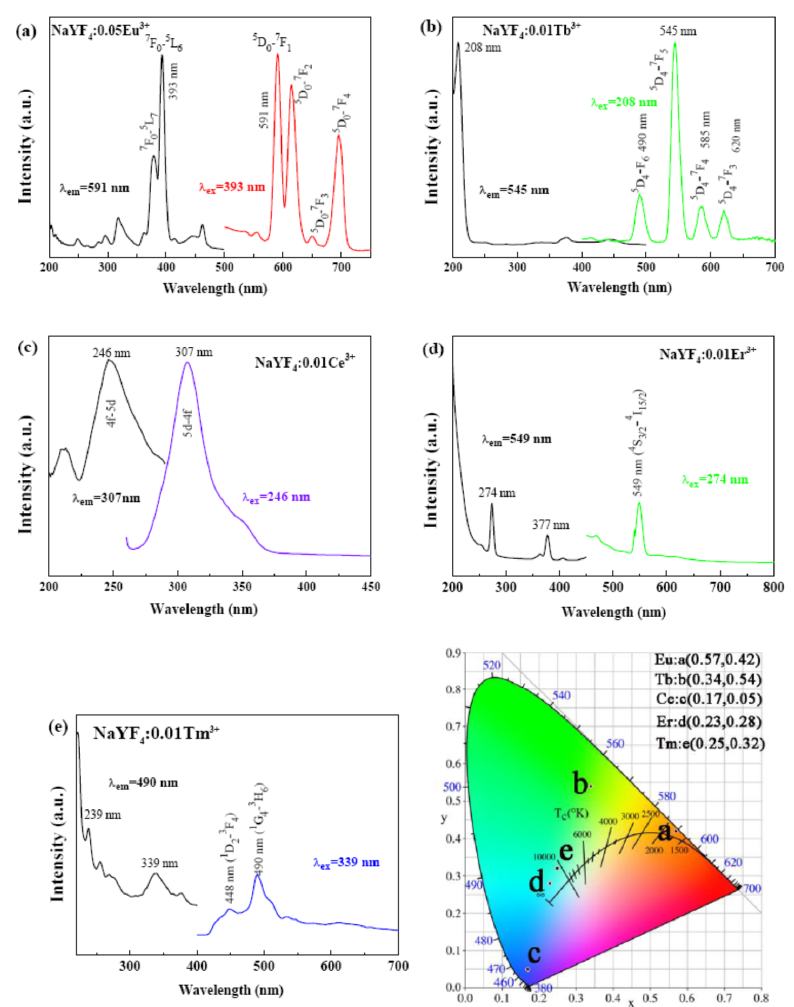
Figure 4. PLE and PL spectra of ( a ) Eu 3 + -, ( b ) Tb 3 + -, ( c ) Ce 3 + -, ( d ) Er 3 + -, and ( e ) Tm 3 + -doped α -NaYF 4 samples calcined at 600 °C. The final part is the corresponding CIE chromaticity diagram.